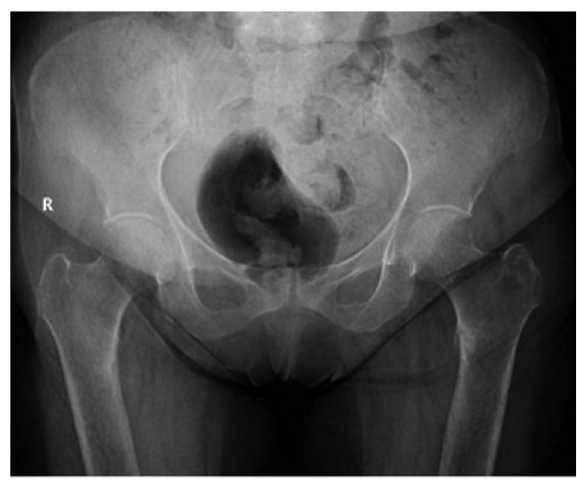
Figure 1. Preoperative antero-posterior pelvis view.